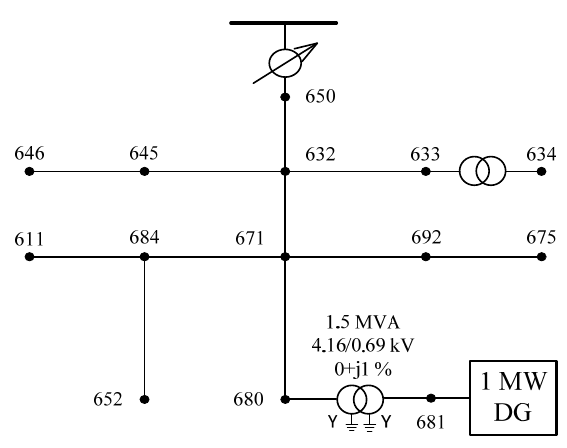
Figure 5. Modified IEEE 13-bus test